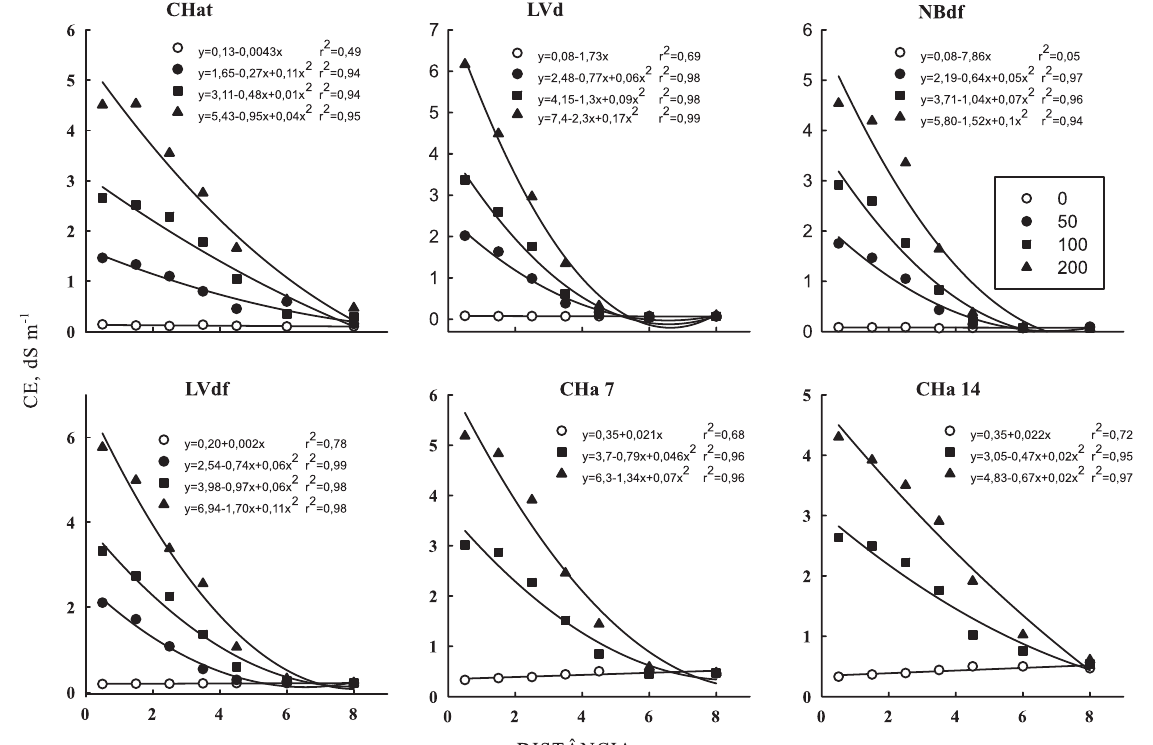
Figura 2. Condutividade elétrica (CE) nos solos em diferentes distâncias a partir da região fertilizada com doses de K O (kg ha -1 ) na forma de KCl. Média de quatro repetições. CHa: Cambissolo Húmico Alumínico 2 léptico; CHat: Cambissolo Húmico Alumínico típico; NBdf: Nitossolo Bruno distroférrico típico; LVdf: Latossolo Vermelho distroférrico; LVd: Latossolo Vermelho distrófico. No CHat, não foi utilizada a menor dose (50 kg ha -1 de K 2